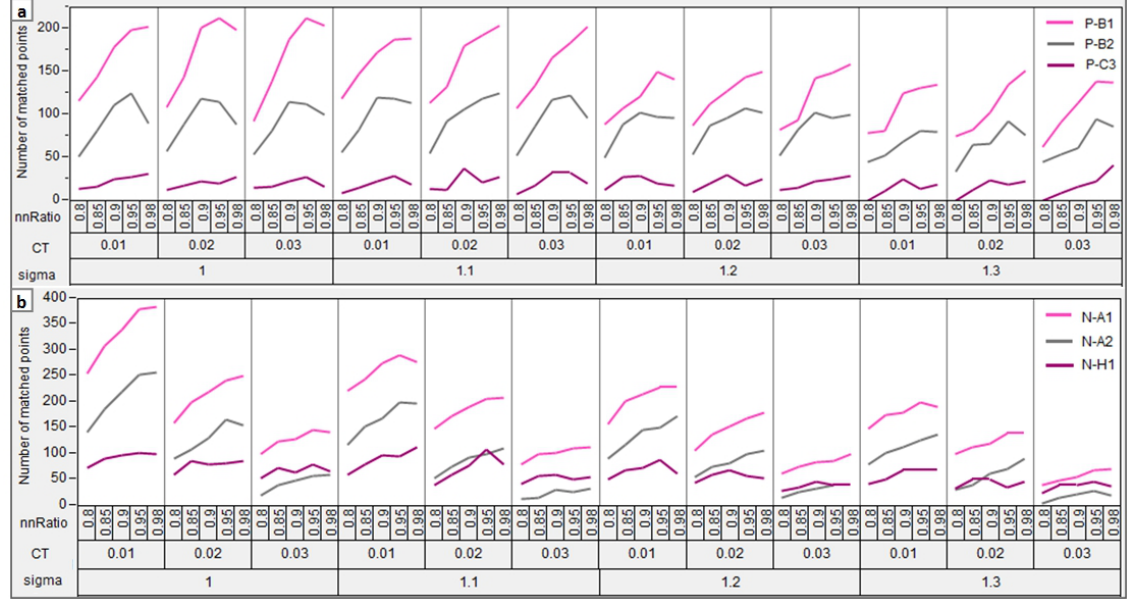
Figure 10. Total number of points matched in nine bands of the hyperspectral images from the Pozalagua quarry ( a ) and the TT Niche tunnel ( b ), depending on chosen SIFT parameters: the initial smoothing for the first level of each octave (sigma), contrast threshold and nearest neighbor ratio (nnRatio) values. Number of scales in each octave (nScales) equal to